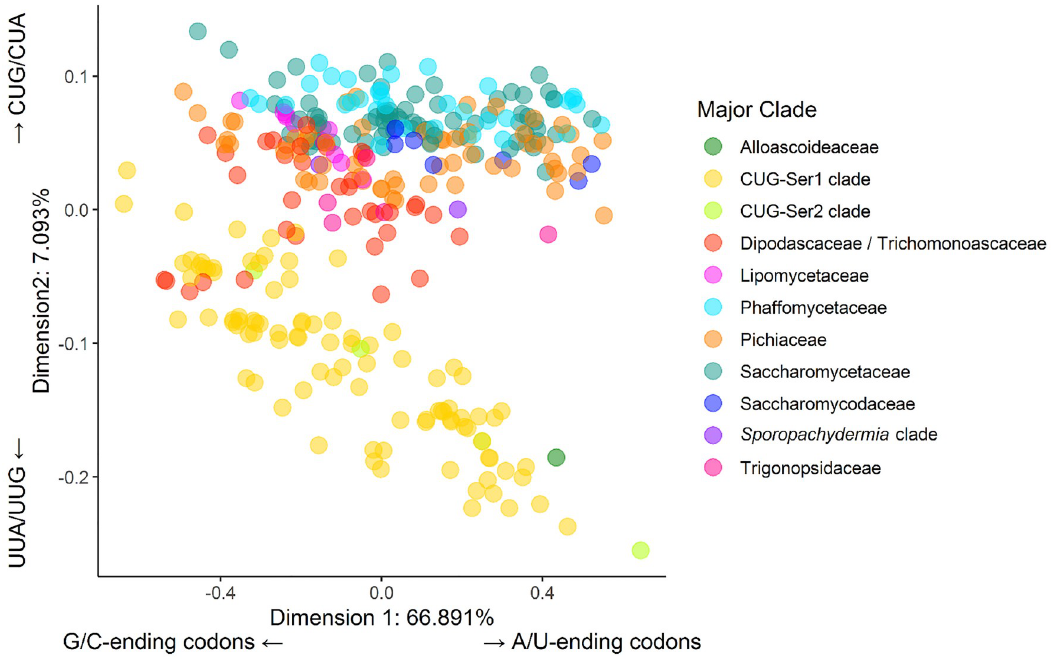
Fig 2. Differences in relative synonymous codon usage values between species are largely driven by variation in the usage of G/C- and A/U-ending codons. The plot shows each of the 327 budding yeast species examined in this study along the first two dimensions (the X and Y axes) of a correspondence analysis. Each axis is labeled with the percent variance explained by the corresponding dimension and the codons that are the major drivers of the observed variance. The first dimension, which explains nearly 67% of the variation between species, is driven by the differential usage of G/C- versus A/U-ending codons. The second dimension, which differentiates the CUG-Ser1 clade, the CUG-Ser2 clade, and one Alloascoideaceae species from the rest of the species in the subphylum, explains a much smaller fraction of the observed variation (about 7%) and is primarily driven by differential usage of the CUA, CUG, UUG, and UUA codons in the two